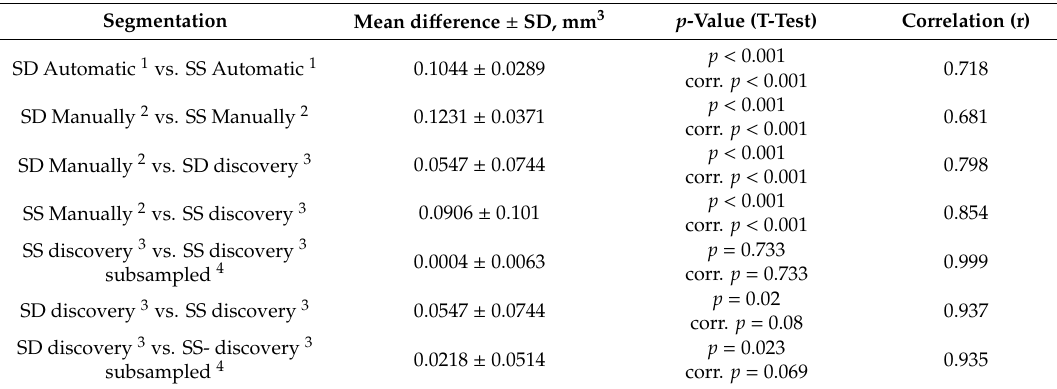
Table 2. Inter-device comparison between SD-OCT and SS-OCT